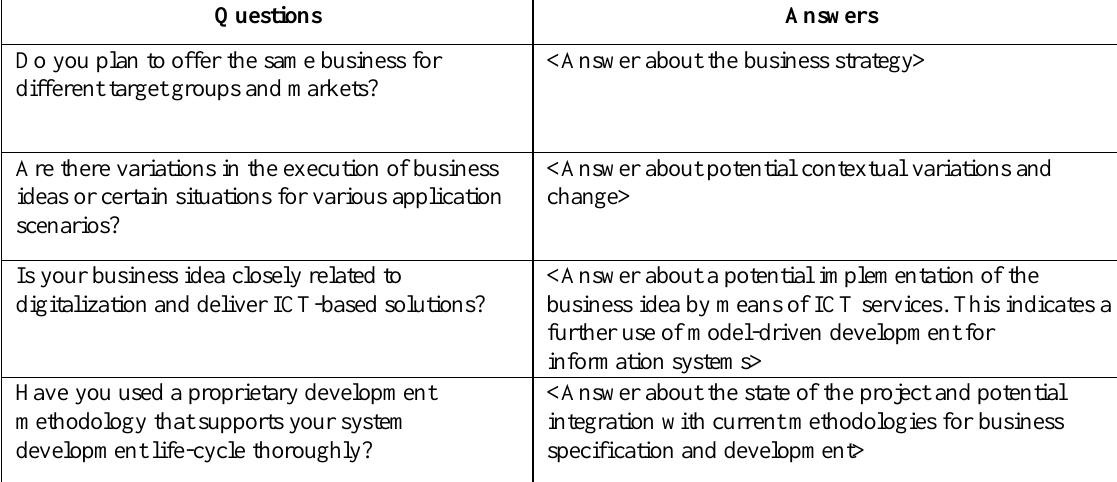
Table 2. Template to produce the output of the first